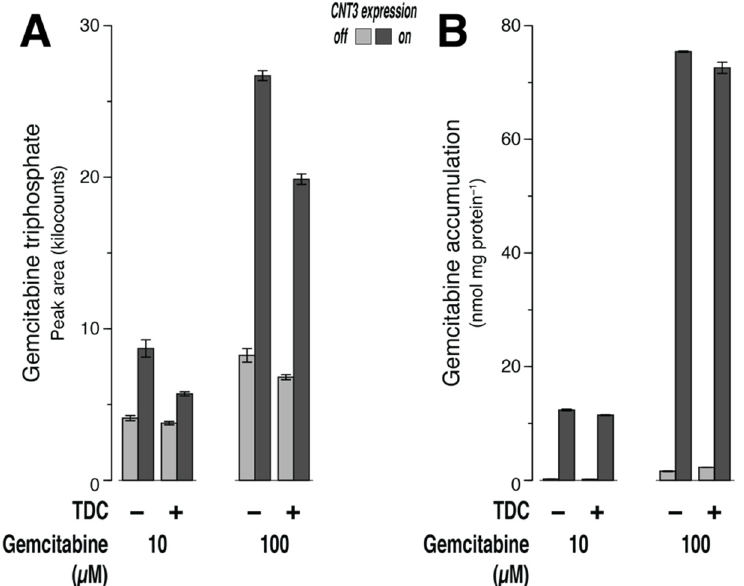
Figure 4. TDC inhibits the generation of gemcitabine triphosphate ( A ), but this does not increase gemcitabine ( B ). Cells without or with CNT3 expression were preincubated for 1 h with uptake buffer or with 10 µ M 2-thio-2 (cid:48) -deoxycytidine (TDC) in uptake buffer, washed twice with ice-cold uptake buffer, and then incubated for 15 min at 37 ◦ C with 10 or 100 µ M gemcitabine + 100 nM NBMPR in uptake buffer. See legend in Figure 1 for further